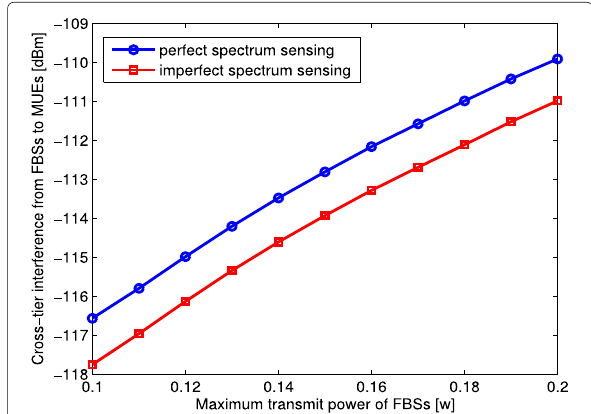
Fig. 7 Cross-tier interference from FBSs to